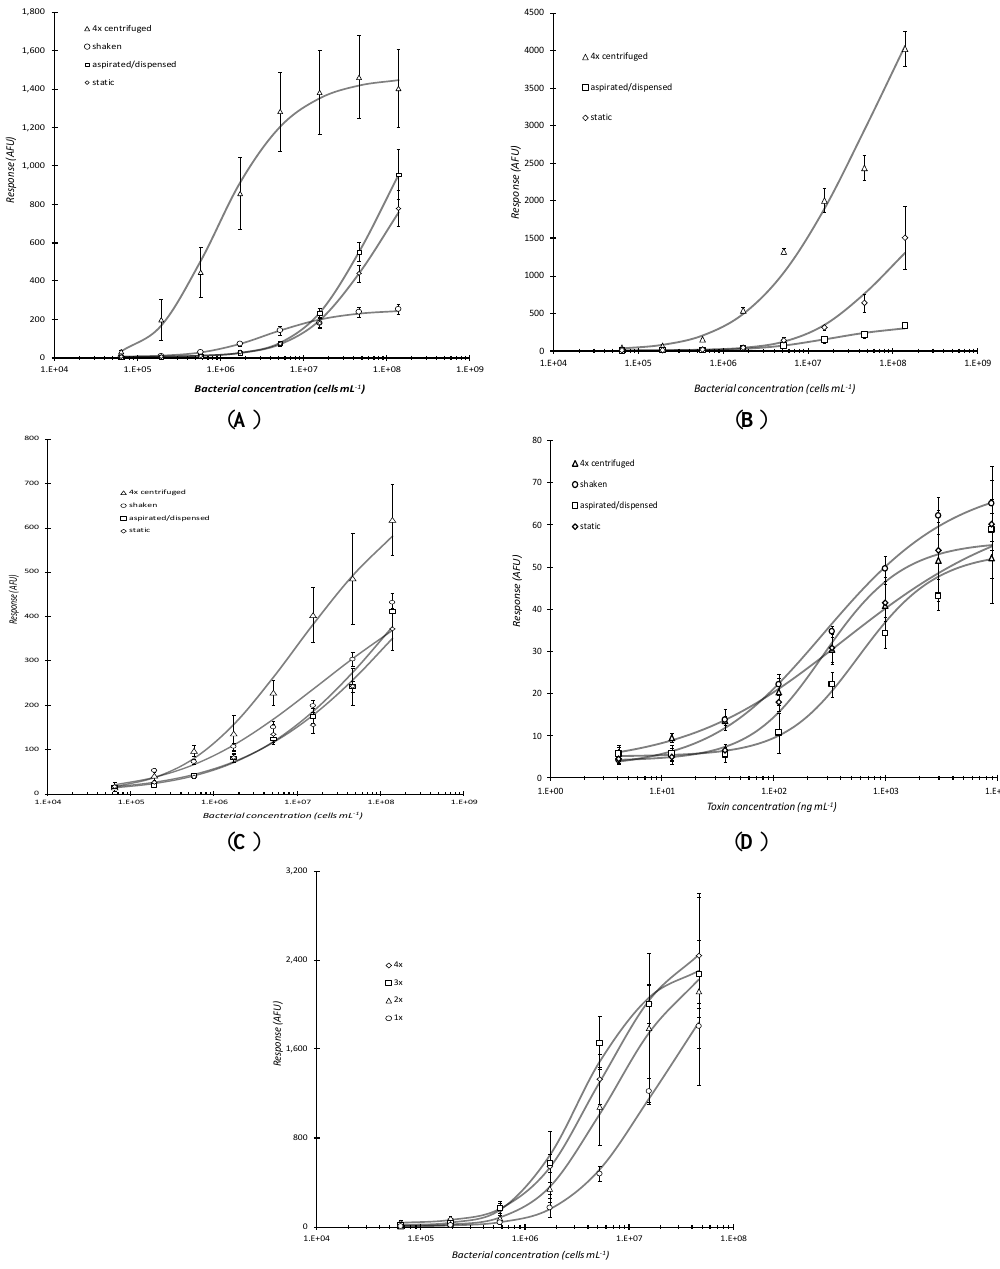
Figure 3. Comparison of incubation conditions in microarray detection of bacteria. Serially diluted analyte, live E. coli O157:H7, captured by passively adsorbed biotinylated ( A ) or non-biotinylated anti- E. coli O157:H7 antibody ( B ), heat-killed E. coli O157:H7 captured by biotinylated anti-O157:H7 antibody ( C ), or Stx1 captured with biotinylated anti-Stx1 antibody ( D ) were subjected to